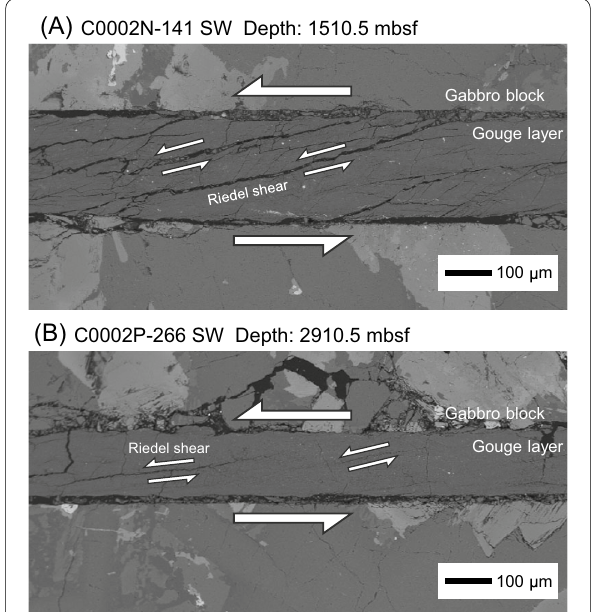
Fig. 7 Back-scattered electron images of the recovered samples A C0002N-141SW and B C0002P-266SW. The gouge layer is sandwiched between the gabbro forcing blocks, and the arrows in the blocks indicate slip directions. Riedel shears are widely developed in these samples. These images were taken using an electron-probe microanalyzer with a 15-kV accelerating voltage and 2.5 nA probe current Fig. 8 Relationship between the friction coefficient and A total clay